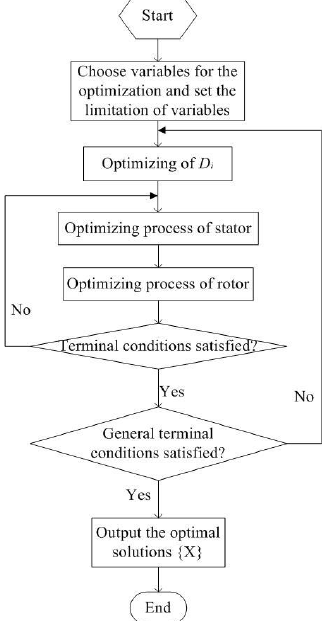
Figure 7. Flow chart of the sub-group optimization.